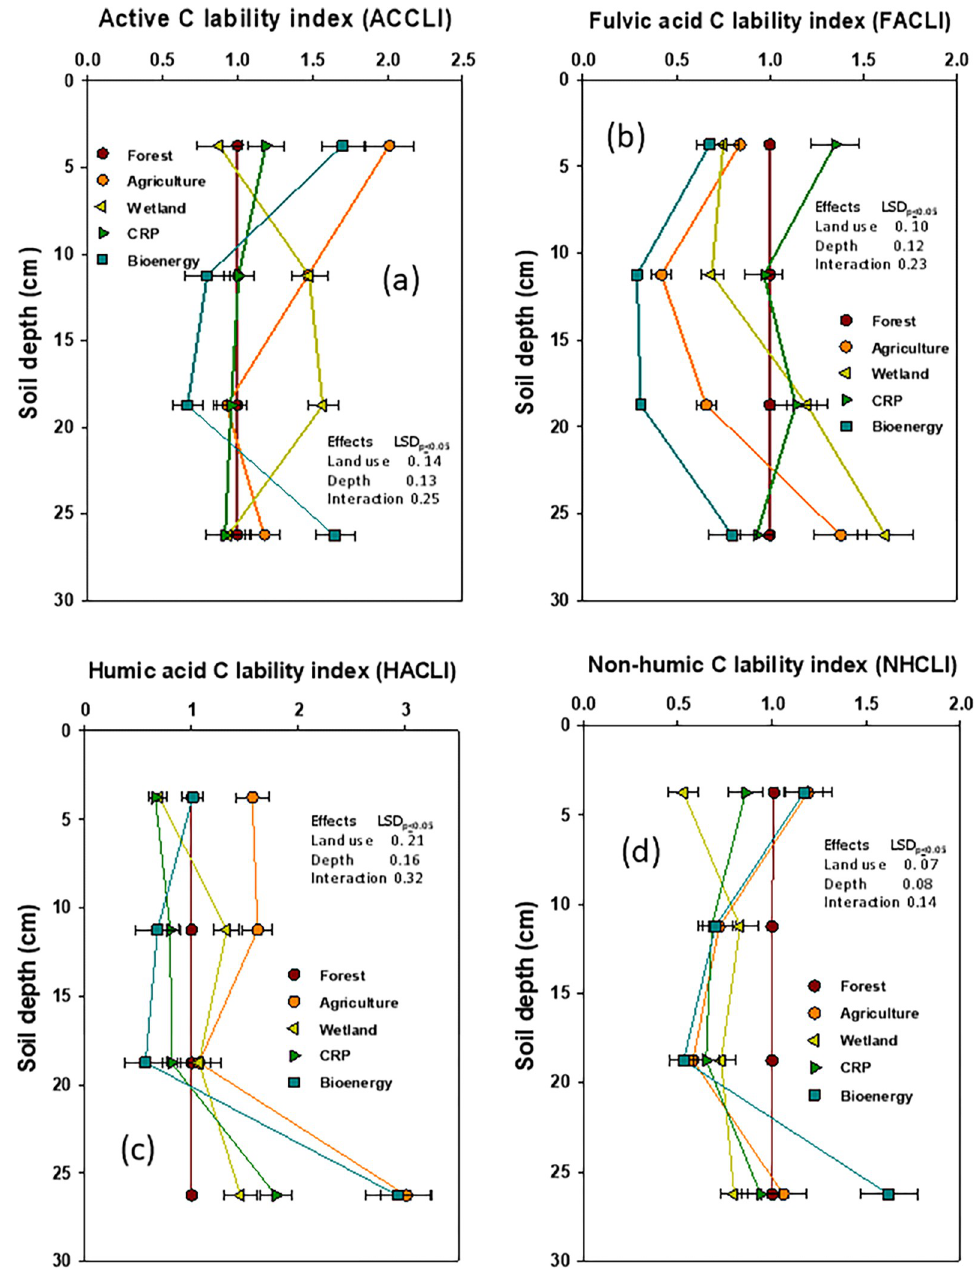
Fig 6. Impact of deforestation and subsequent land-use diversity on active carbon (AC), fulvic acid (FA), humic acid (HA), and glucose equivalent total non-humic carbon (NH) lability indices at different soil depths (data were presented with mean ± standard